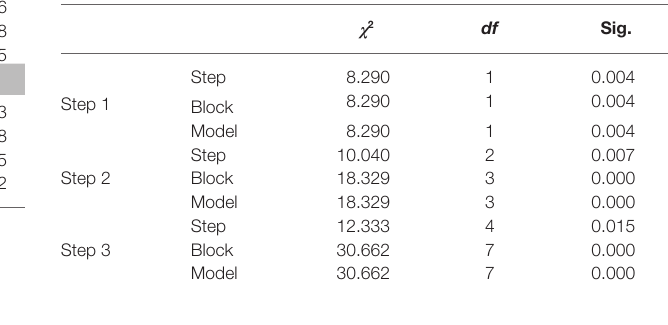
TABLE 5 | Omnibus tests for the confinement conditions model coefficients.